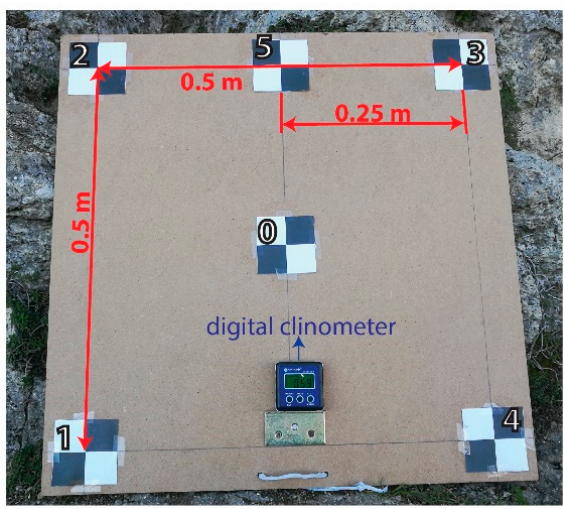
Figure 2. Wooden square and targets used in this study as a reference for the creation of digital photogrammetry (DP) models.